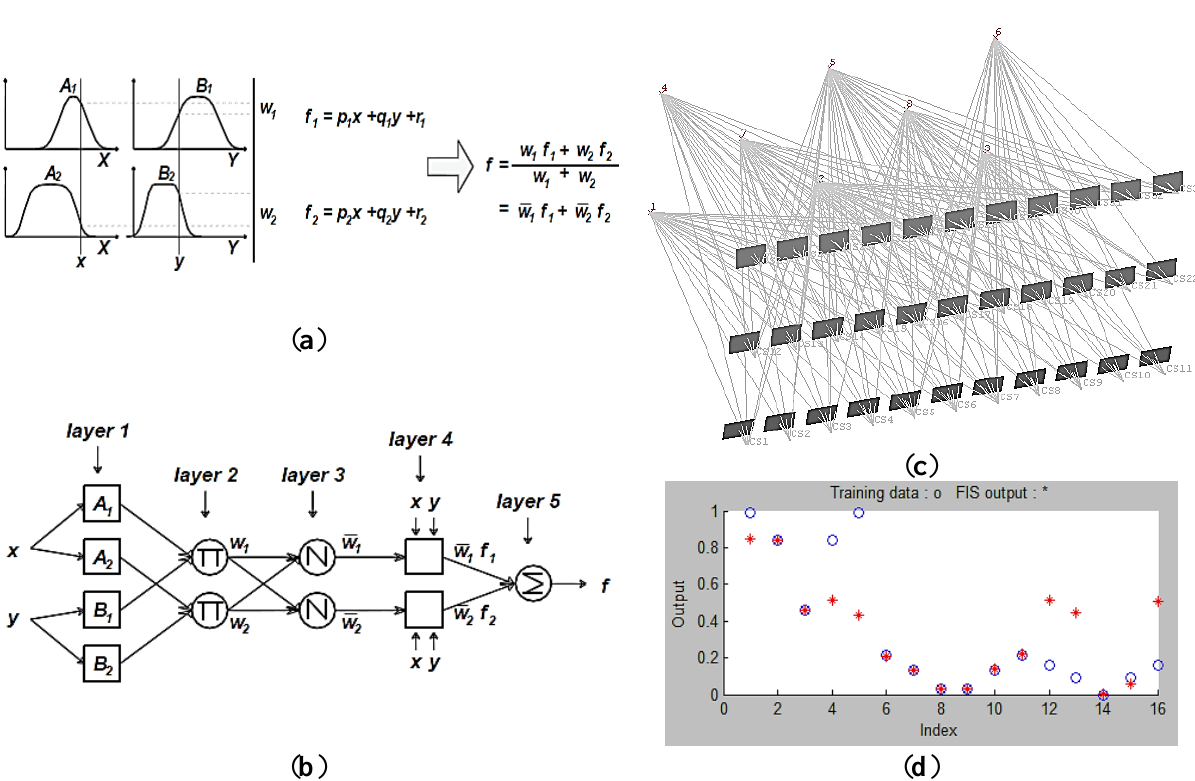
Figure 6. ( a ) First order Sugeno fuzzy model; ( b ) Corresponding ANFIS architecture [21]; ( c ) The data set for learning and checking of ANFIS; ( d ) The MATLAB interface for the ANFIS training and